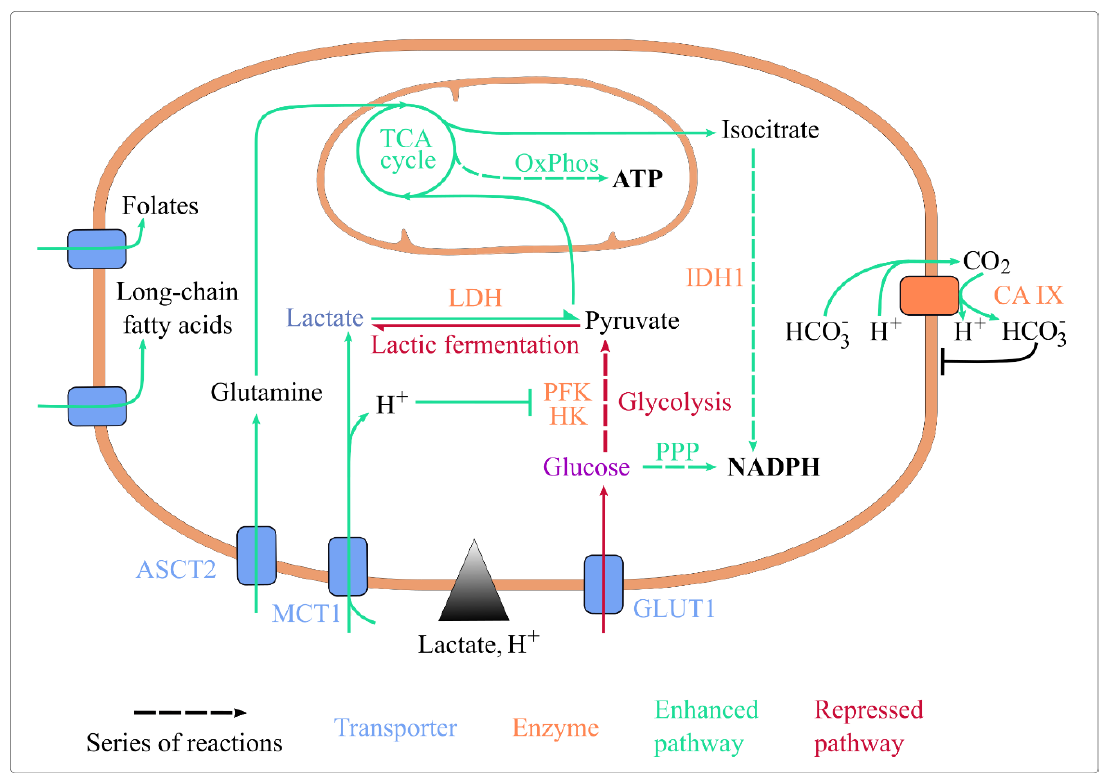
Figure 1. Lactic acidosis rewires energy metabolism and maintains cellular homeostasis. Lactic acidosis enhances the uptake of folate, long-chain fatty acids, glutamine, and lactate. It represses glucose import, glycolysis (by inhibiting HK and PFK, its rate-limiting enzymes) and lactic fermentation. It enhances lactate conversion to pyruvate, routing of pyruvate and glutamine towards the TCA cycle, ATP generation by OxPhos, and coenzyme reduction by IDH1 and the oxidative PPP. It also upregulates CA IX expression, which basifies intracellular pH. Abbreviations: ASCT2: Alanine, Serine, Cysteine Transporter 2; CA IX: carbonate anhydrase 1; GLUT1: glucose transporter 1; HK: hexokinase; IDH1: isocitrate dehydrogenase 1; MCT1: monocarboxylate transporter 1; OxPhos: oxidative phosphorylation; PFK1: phosphofructokinase 1; PPP: pentose phosphate pathway; TCA: tricarboxylic acid.